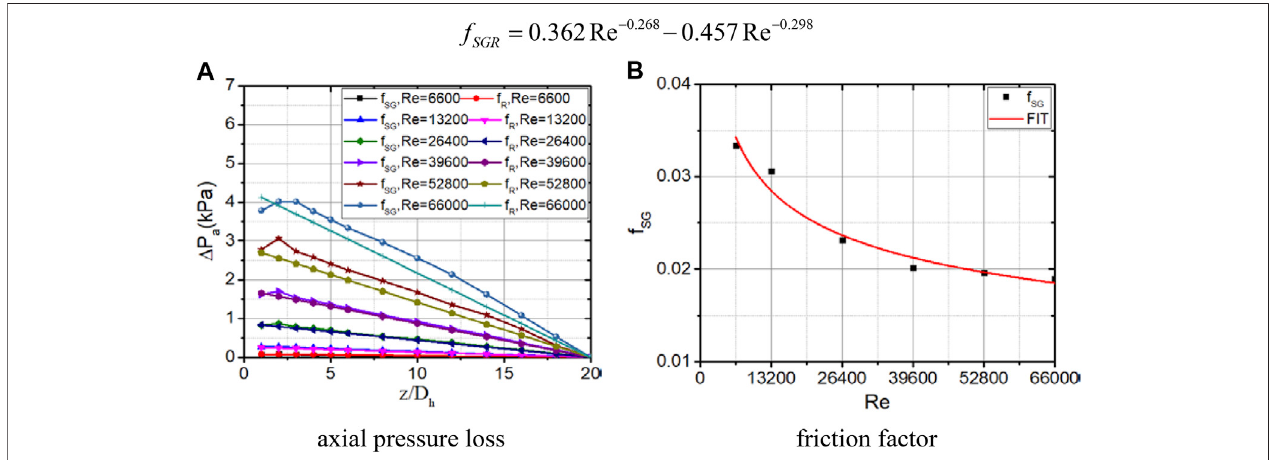
FIGURE 7 | Spacer grid effect on the friction factor downstream of the spacer grid.